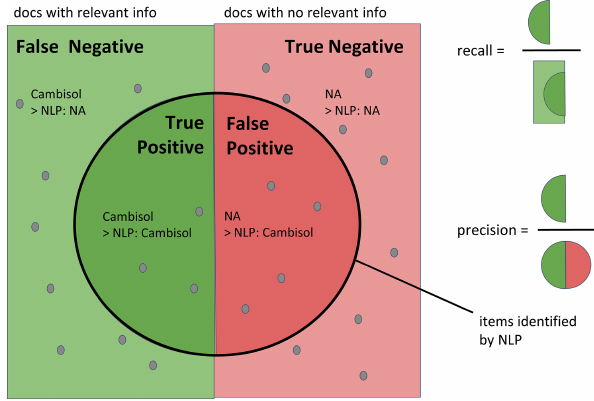
Figure A1. Schematic representation of precision and recall. Recall aims to assess how much relevant information was selected out of all the data available in the corpus, while precision aims to assess how much relevant information was in the selection.